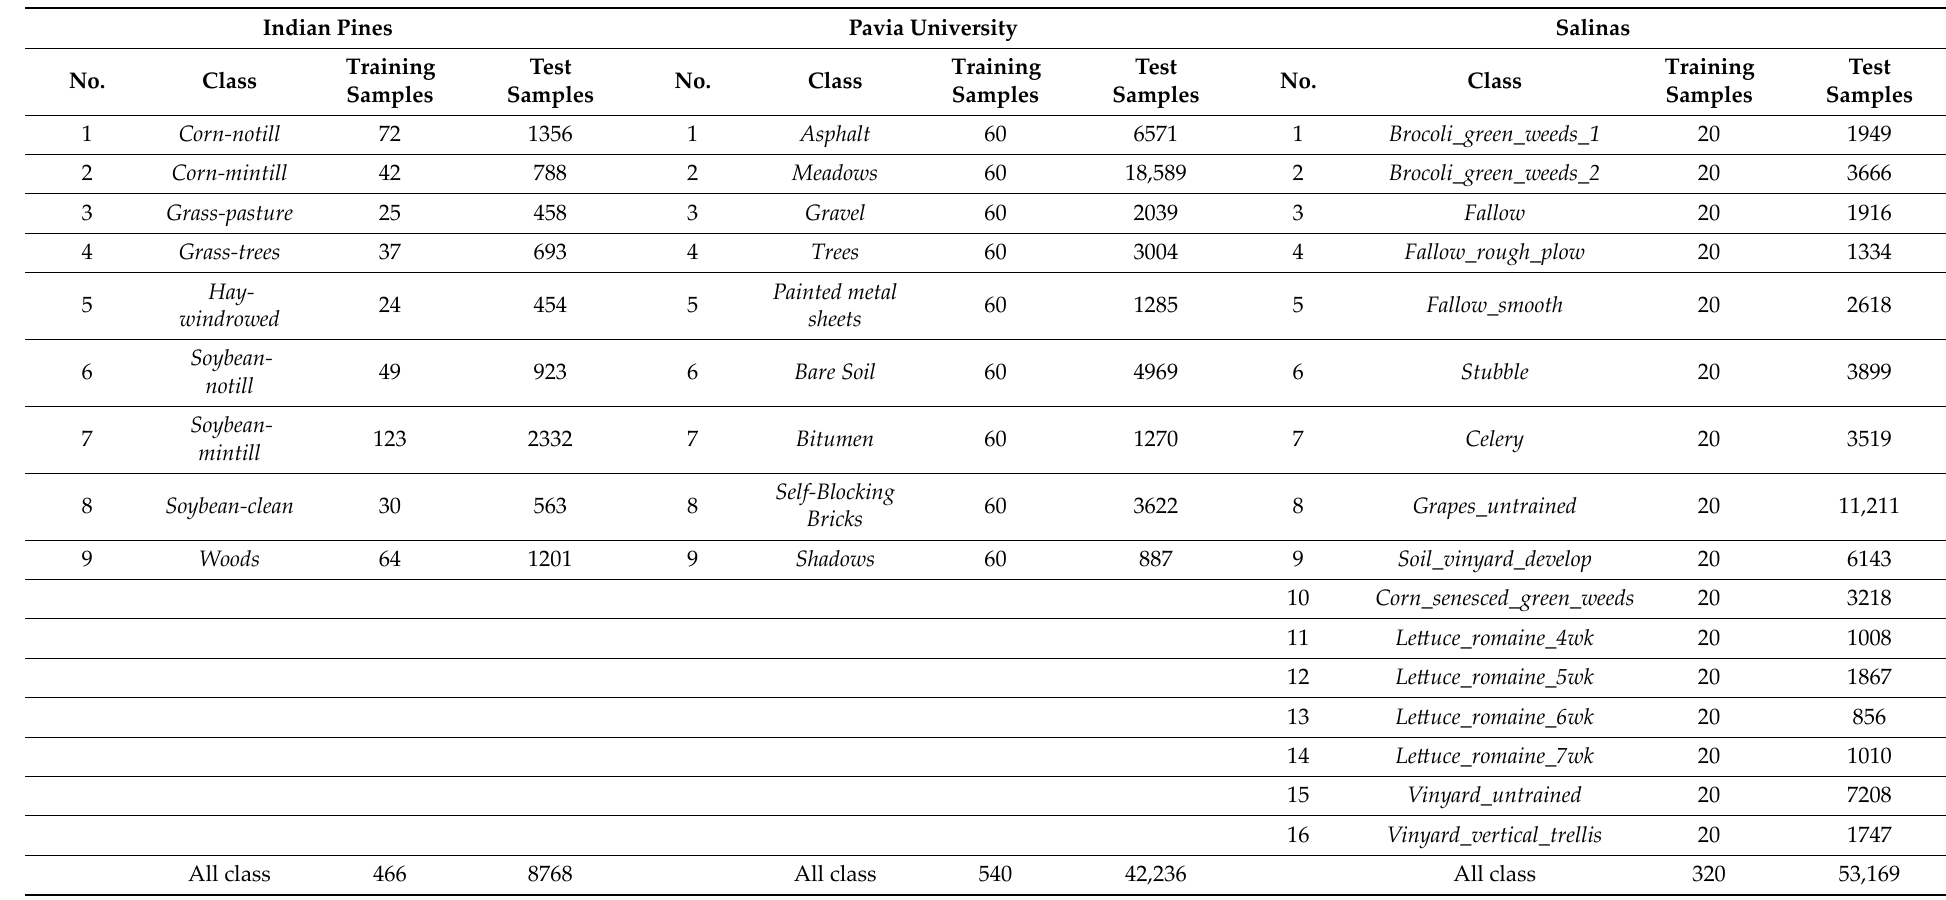
Table 1. The division of samples for the Indian Pines, Pavia University, and Salinas scenes. Indian